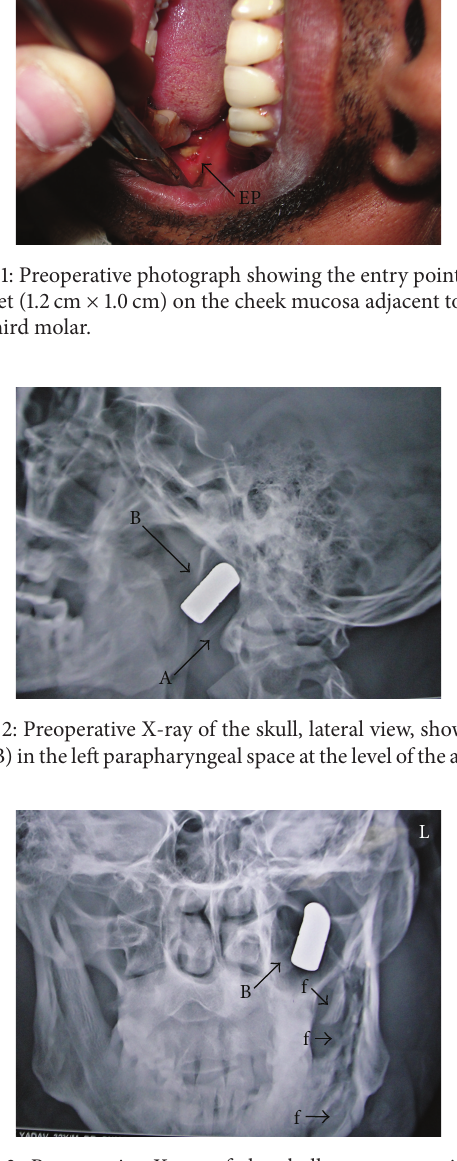
Figure 3: Preoperative X-ray of the skull, anteroposterior view, showing the bullet (B) lying in a sagittal plane passing through the middle of the left maxillary antrum. Note the multiple fracture fragments (f) of the mandible on the left side.